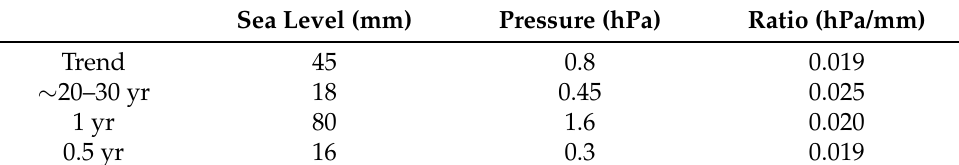
Table 3. Ratios of SSA components of GP to GSLTG with the same periods (see text).